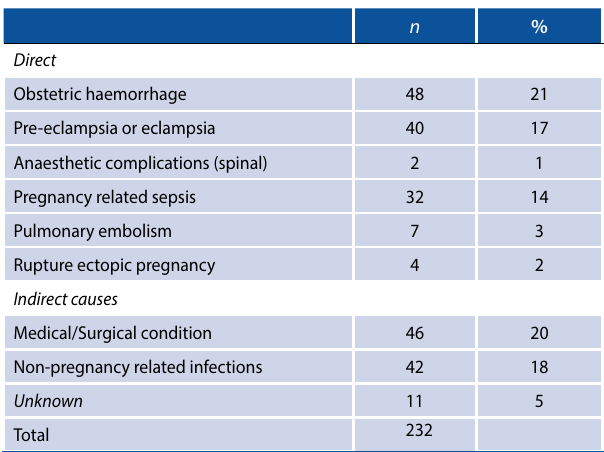
Table 3: The causes of maternal deaths at Pietersburg Hospital (2011– 2015)